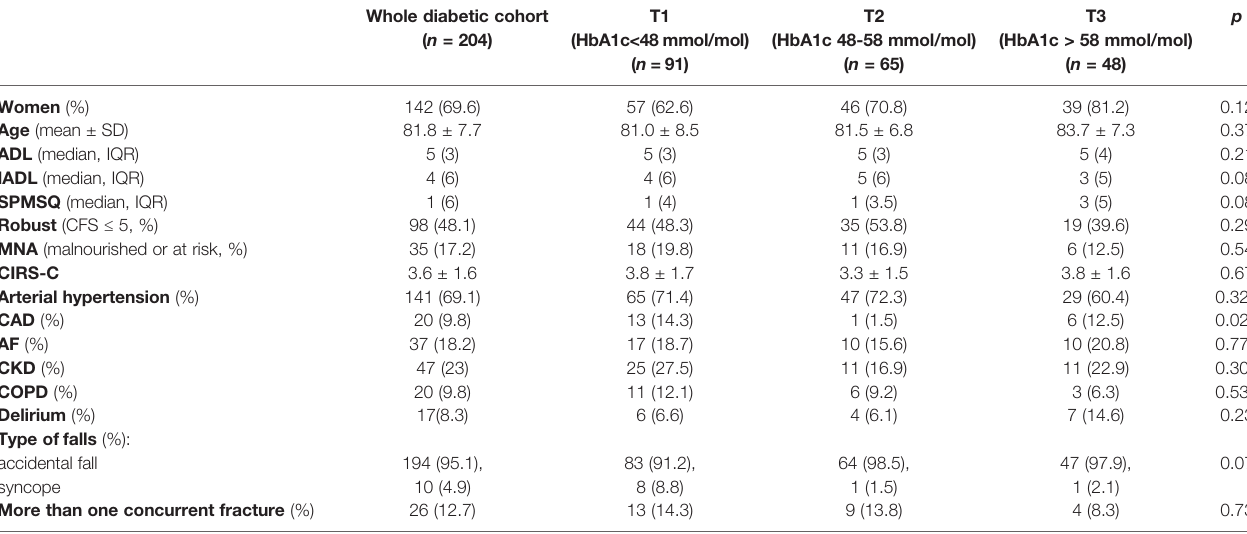
TABLE 2 | Clinical and demographic characteristics of diabetic orthogeriatric patients categorized in tertiles of glycated hemoglobin.